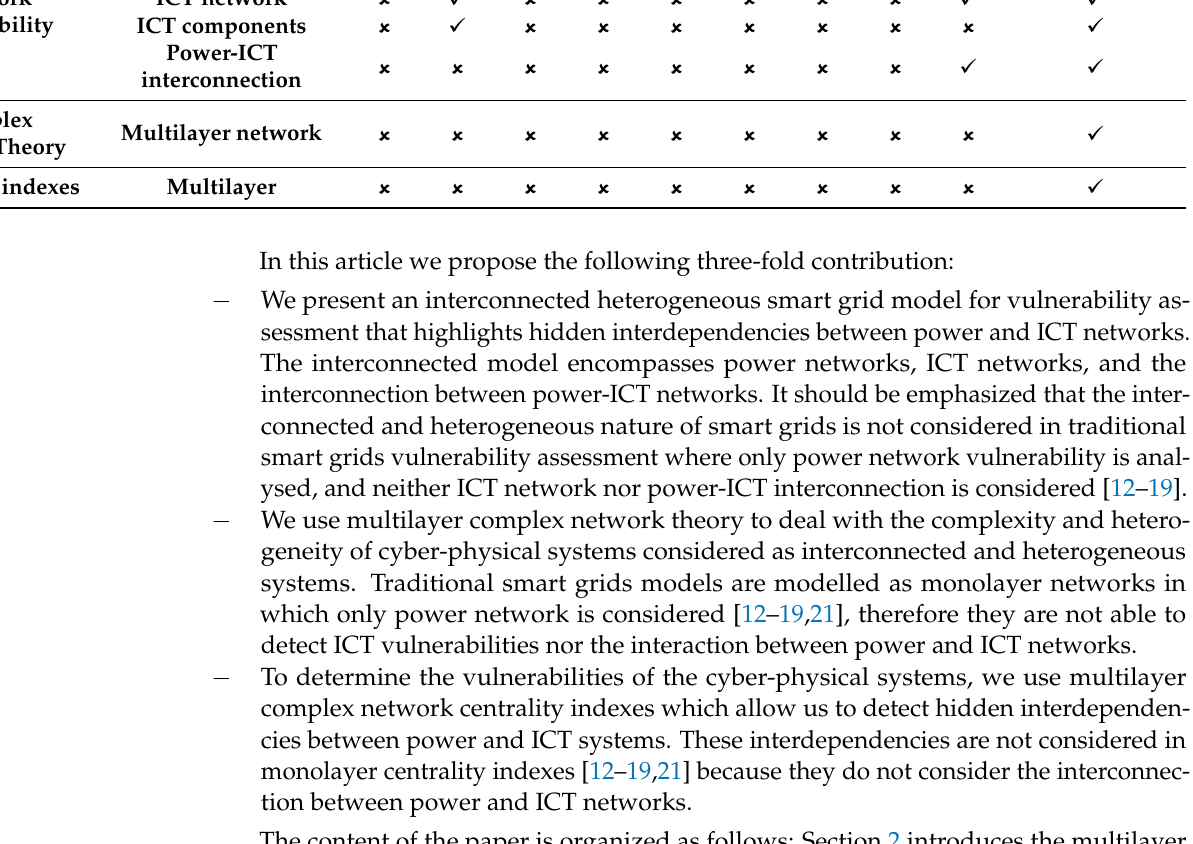
Table 1. Comparison table of related work with the proposed method in this paper.